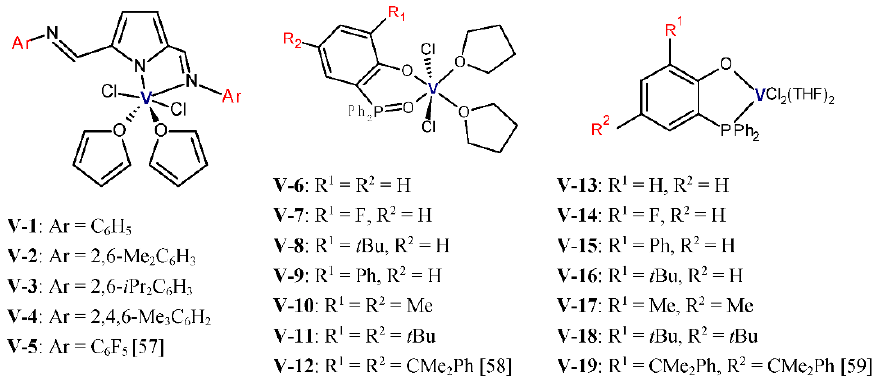
Figure 4. Vanadium complexes with bidentate ligands investigated as precatalysts for ethylene/1-olefin copolymerization [57–59].